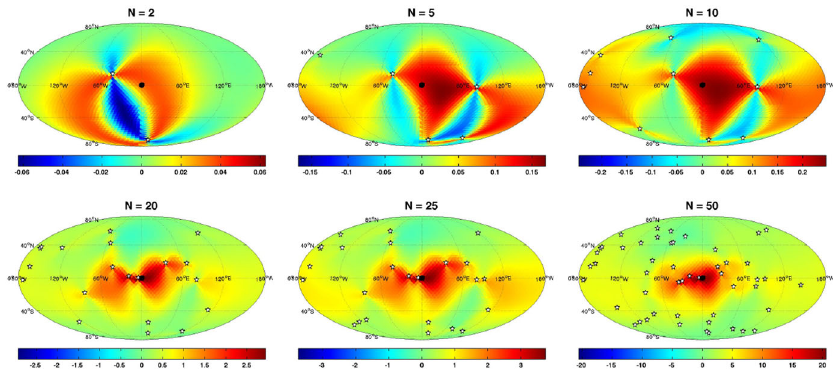
Fig. 47 Point spread functions for gravitational-wave power for pulsar timing arrays consisting of N = 2, 5, 10, 20, 25, 50 pulsars. The point source is located at the center of the maps, (θ,φ) = ( 90 ◦ , 0 ◦ ) , indicated by a black dot . The pulsar locations (indicated by white stars ) are randomly placed on the sky. The point spread function becomes tighter as the number of pulsars in the array